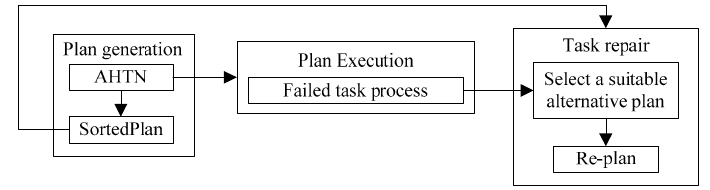
Figure 2. Overall framework of the adversarial hierarchical task network (AHTN)-R algorithm.